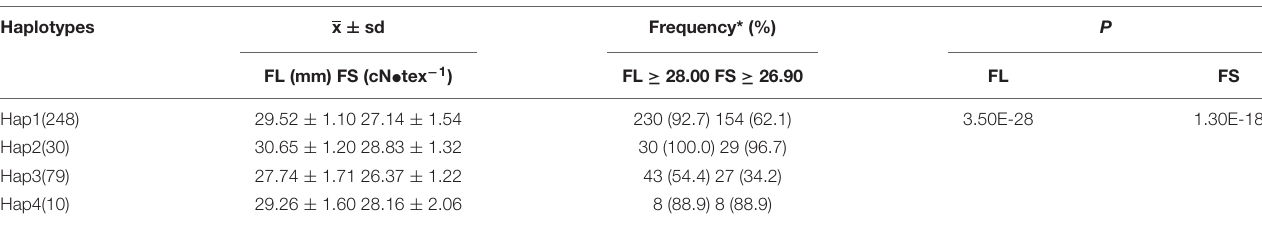
TABLE 5 | The effects and frequencies of different haplotypes in the core cotton collection of 419 accessions.